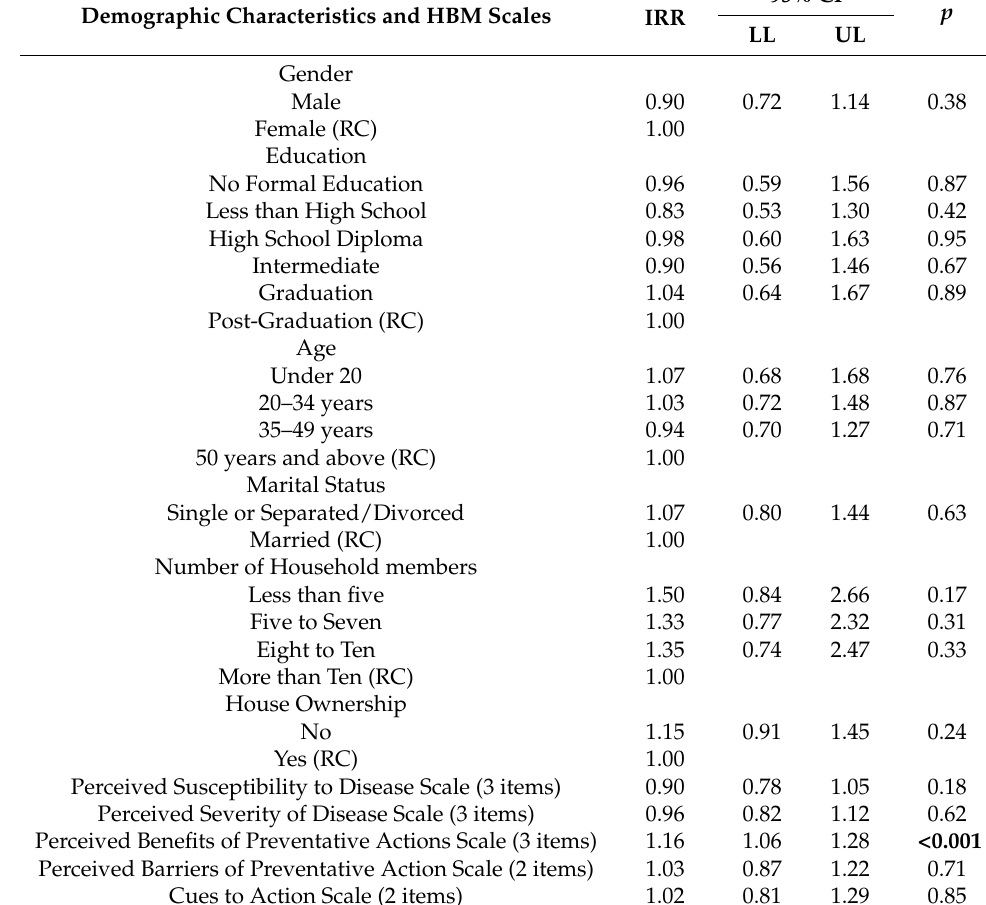
Table 4. Negative binomial regression of the COVID-19 prevention behaviors (scale score) *, Depalpur City, Pakistan,